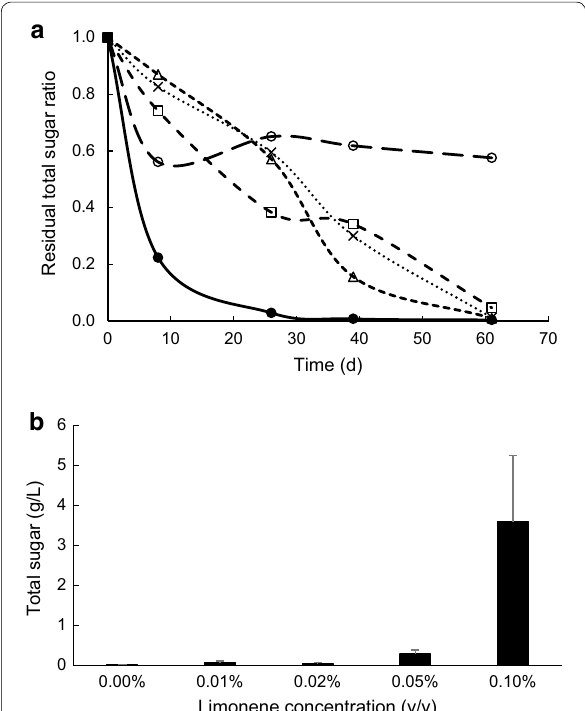
Fig. 4 a Residual total sugar ratio in the culture medium with C. cellulovorans , where different concentrations of limonene (v/v), 0% (filled circle), 0.01% ( ), 0.02% (open triangle), 0.05% (open square), × and 0.1% (open circle), was present in the culture medium. b Total Fig. 5 Total sugar concentration in the culture medium containing sugar concentration at 61 days cultivation. Values are mean SE of removed peel ( a ) and strained lees ( b ) degraded with or without C. ± three independent samples cellulovorans . Values are mean SE of three independent samples. An ± asterisk indicates a significant difference (p <